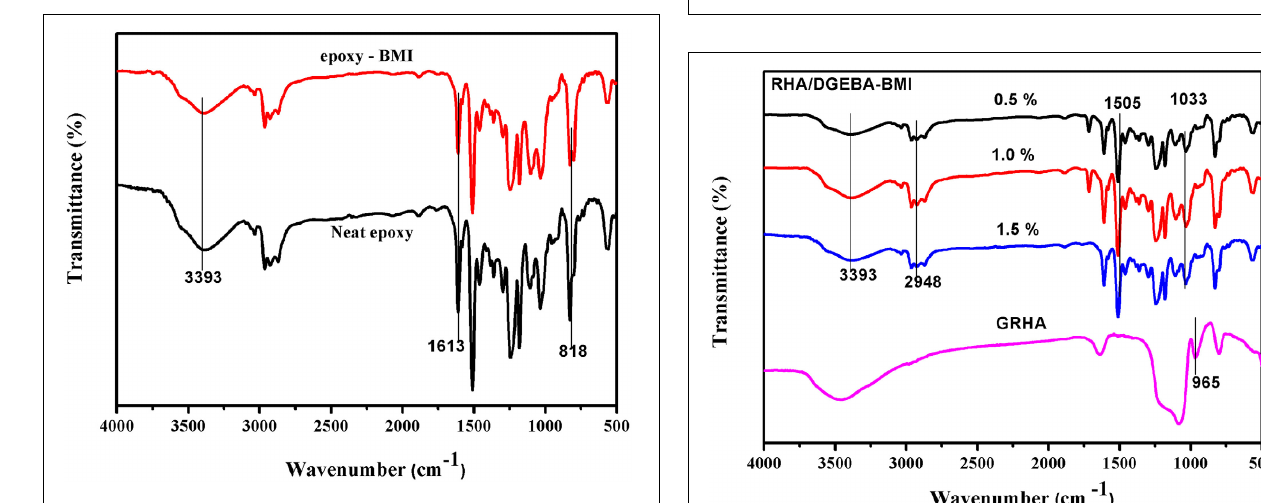
FIGURE 5 | TGA of RHA and glycidyl functionalized rice husk ash.